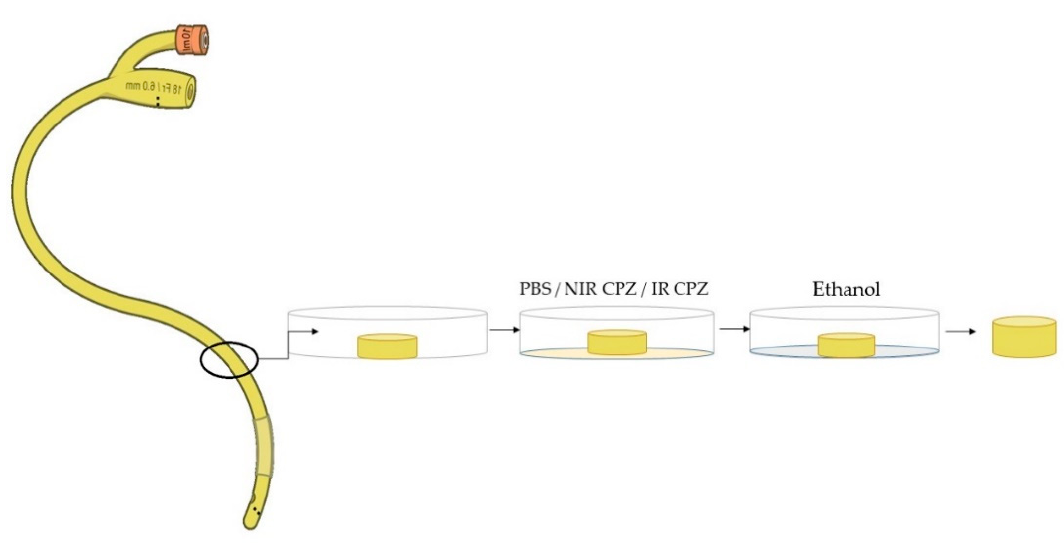
Figure 1. The protocol for the immersion of urinary catheter segments with non-irradiated/irradiated CPZ or PBS control. Legend: PBS = phosphate-buffered saline, NIR-CPZ = non-irradiated CPZ and IR-CPZ = irradiated CPZ.